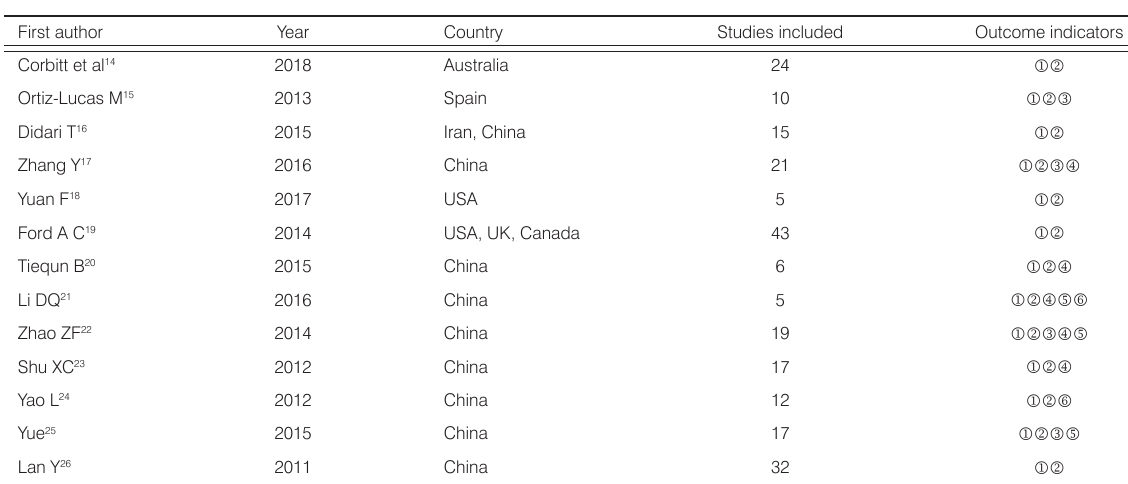
Table 1. Summary of the 13 meta-analyses or systematic reviews that qualified for this review.